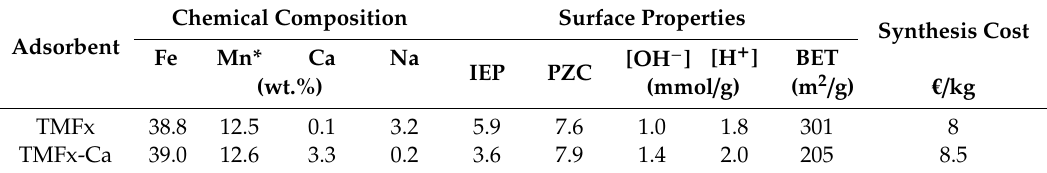
Table 1. Main physicochemical characteristics and the respective preliminary cost analysis of the prepared